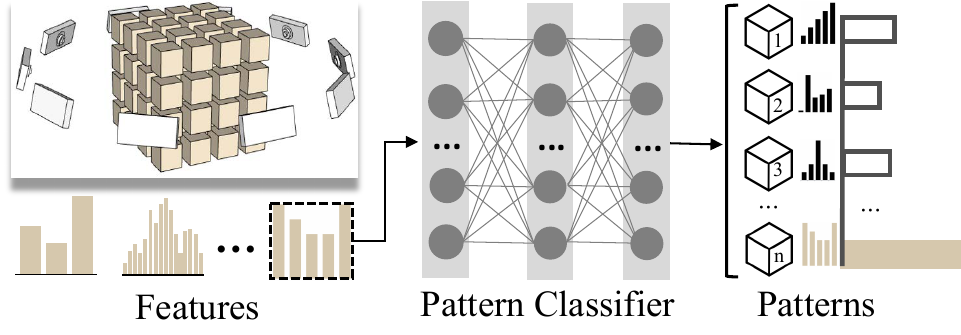
Figure 1. The basic idea of a pattern classifier, i.e., classifying an input visualization to a pattern class. A pattern classifier differs from an image classifier significantly. Each image inherently belongs to a class. In contrast, pattern classes are artificial, and analysts know little about the patterns of a dataset before exploring it. As the analyst generates and reads visualizations, the number of recognized patterns gradually increases. Even though we can initialize a PC through manual sampling and labeling [10–13], the PC inevitably classifies a newly generated visualization that contains never-encountered patterns into an existing class during